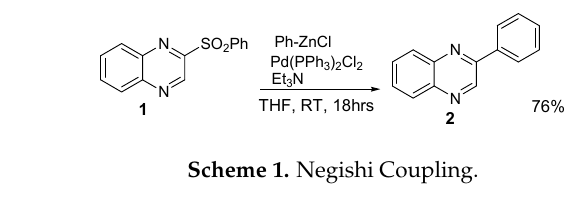
Table 1. Nucleophilic substitution on 2-phenylquinoxaline.